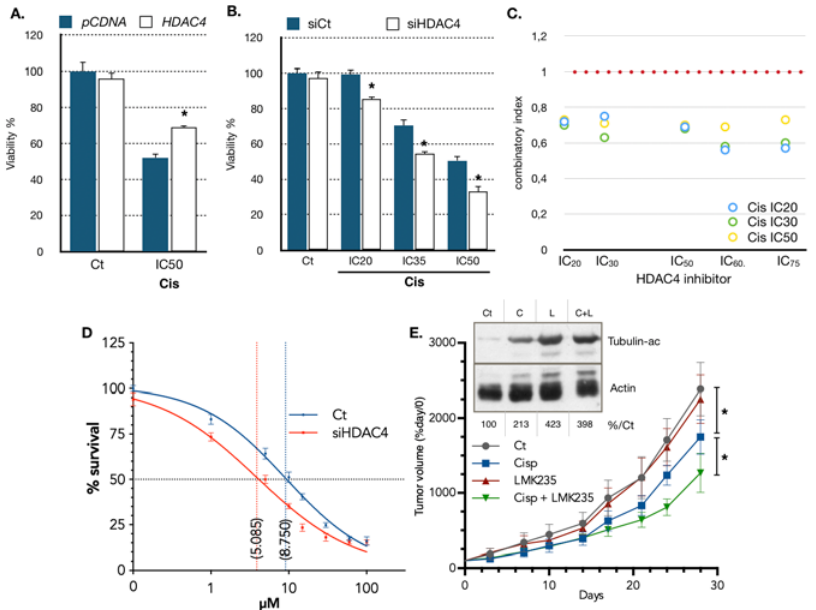
Figure 3. Function of HDAC4 expression in gastric cancer in response to cisplatin. ( A ) AGS cells were plated in 96-wells plates, transfected with a plasmid (0.05 µ g) encoding for HDAC4 (pHDAC4) or an empty vector (pcDNA3, Ct) for 24 h and treated for 48 h with the indicated concentration of cisplatin. The viability of the cells was evaluated using a MTT test. *, p < 0.001 ( n = 4), compared with the control, as calculated by one-way ANOVA test followed by a Tukey post-test. ( B ) AGS cells were plated in 96-well plates and transfected with a siRNA (10 nM) against HDAC4 or luciferase (10 nM, siCt) for 48 h and treated for 48 h with the indicated concentrations of cisplatin. The viability of the cells was evaluated using a MTT test. *, p < 0.001 ( n = 4), compared with the control, as calculated by one-way ANOVA test followed by a Tukey post-test. ( C ) Combinatory indexes of treatment with LMK-235 and cisplatin. AGS cells were treated with a combination of increasing concentration of LMK-235 and cisplatin and the cytotoxicity was evaluated by MTT after 48 h of treatment. The graph represents combination indexes for cisplatin concentration of IC 20 , IC 30 , and IC 50 combined with IC 20 , IC 30 , IC 50 , IC 60 , and IC 75 of LMK-235. Combination indexes are inferior to 0.80, indicating a synergistic e ff ect between LMK-235 and cisplatin on AGS cell survival. ( D ) HSC39 cells were plated in 96-well plates and transfected with a siRNA (10 nM) against HDAC4 or luciferase (10 nM, siCt) for 48 h and treated for 48 h with the indicated concentrations of cisplatin. The viability of the cells was evaluated using an MTT test. IC 50 were statistically di ff erent, p = 0.016 ( n = 5), compared with the control, as calculated by the t -test. ( E ) HSC39 cells were implanted intradermal in nude mice. Mice were treated when tumor reached 150 mm 3 with cisplatin (10 mg / Kg) or LMK235 (5 mg / Kg) or a combination of both once a week. Tumor size was monitored twice a week using a caliper. * indicate p < 0.05 as calculated by t -test. Inset: Western blot of acetylated tubulin (K40) and actin performed on tumor extracts at 28 days. Ct: Control; C: Cisplatin; L: